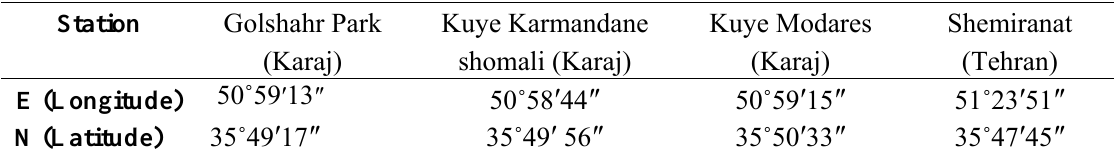
Table 3. The geographic location of Iranian sampling stations where H. pluvialis were found.